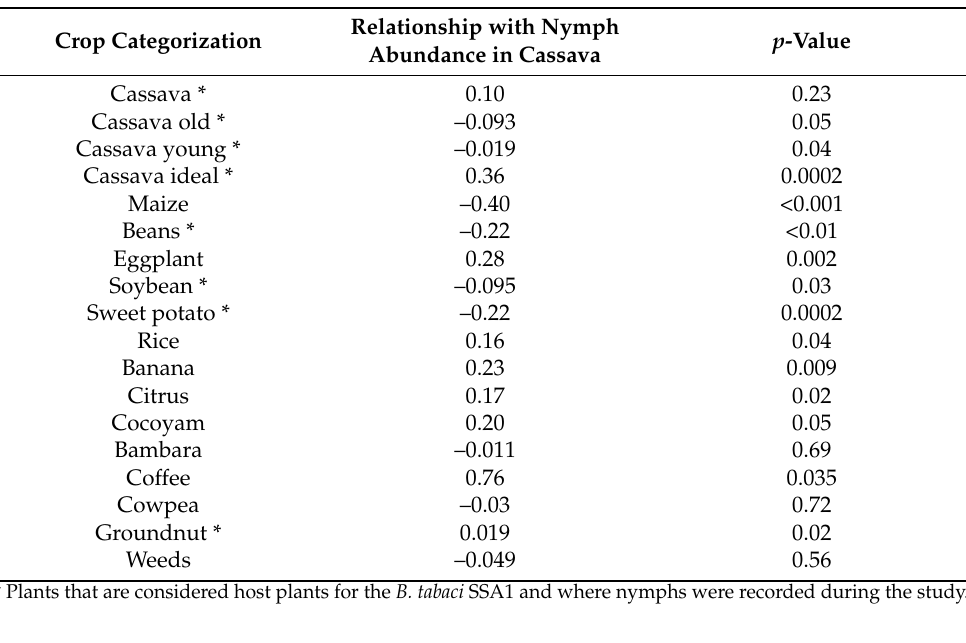
Table 3. Summary table of correlation coefficients (Spearman’s rank correlation) between land-use types in landscapes and B. tabaci SSA1 nymph abundance in cassava across time.